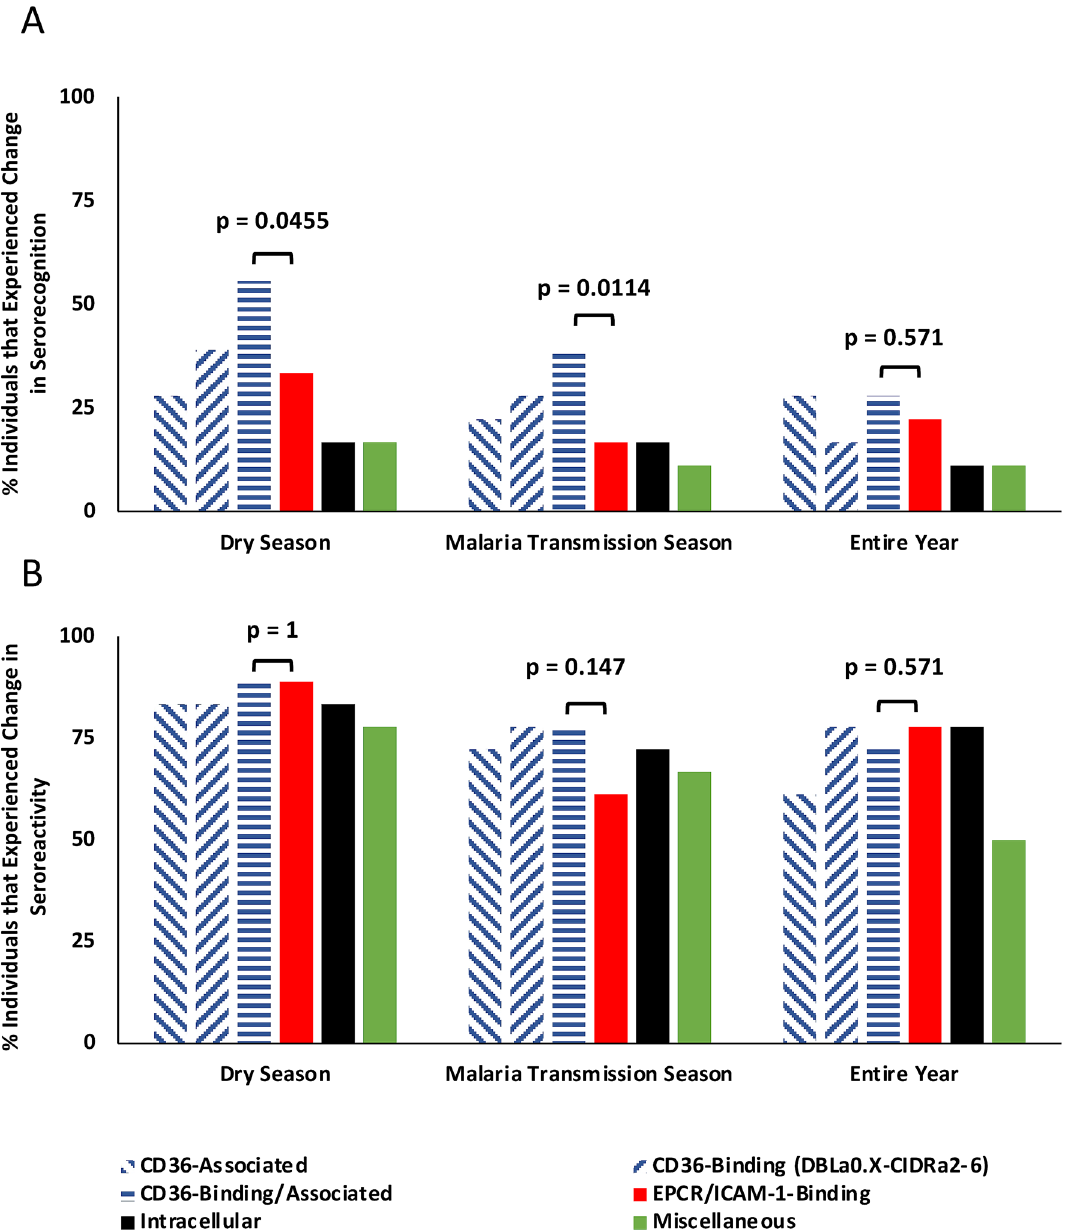
Figure 5. Serorecognition of the combined subgroup of CD36-binding and CD36-associated Plasmodium falciparum erythrocyte membrane protein-1 (PfEMP1) fragments changed more frequently than did serorecognition of EPCR/ICAM-1-binding PfEMP1s. Depicted are the proportions of individuals that experienced change in serorecognition ( A ) and seroreactivity ( B ) of the combined subgroup of CD36- binding and CD36-associated (horizontal blue stripes) and EPCR/ICAM-1-binding PfEMP1s (red) PfEMP1s (determined by the McNemar’s or binomial test) across the dry season, malaria transmission season (MTS), and entire year. CD36-binding, CD36-associated, and intracellular subgroups are shown separately for comparison. 2 P values indicate χ comparisons between the combined CD36-binding/associated subgroup (actual) and EPCR/ICAM-1-binding PfEMP1s counts (expected). “CD36-associated” refers to a PfEMP1 fragment downstream from the CIDR α domain of a known CD36-Binding 3D7 PfEMP1. CIDR cysteine-rich interdomain regions, DBL Duffy binding-like, ATS acidic terminal segment, EPCR Endothelial protein C receptor, ICAM-1 Intercellular adhesion